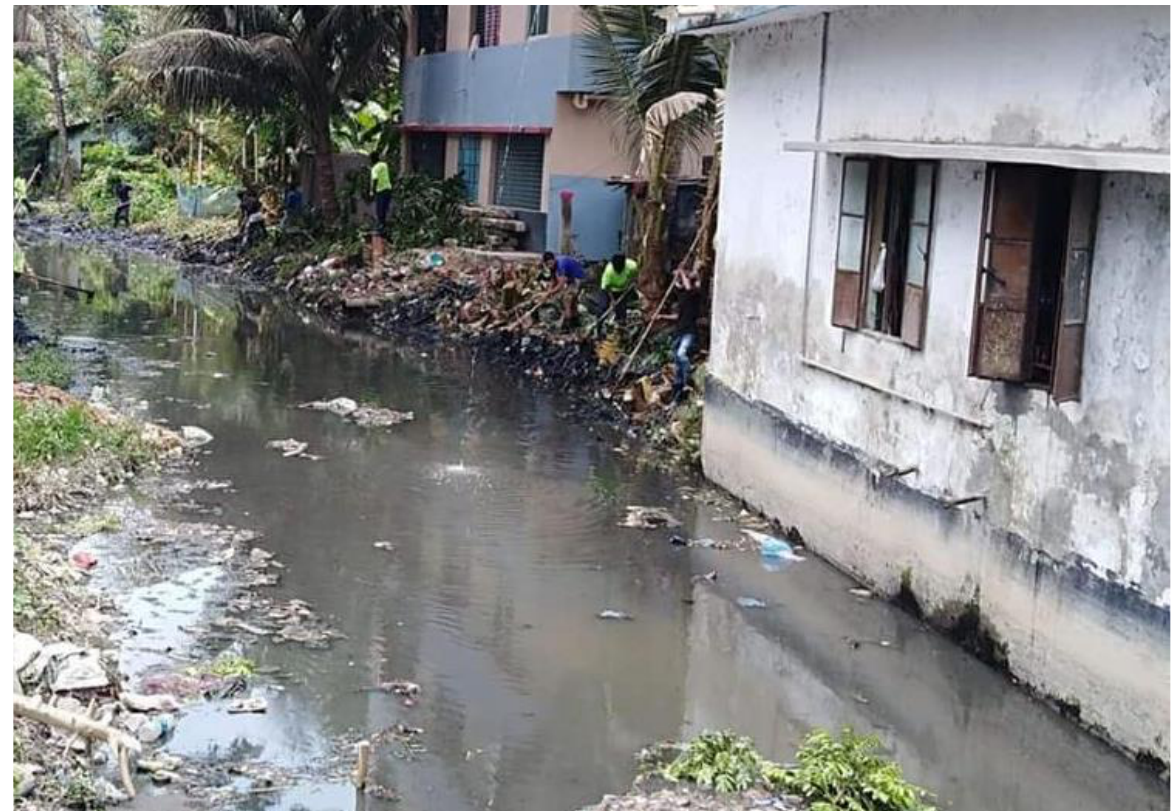
Figure 2. Volunteers cleaning up the Jail canal in Barishal in 2016 [38].